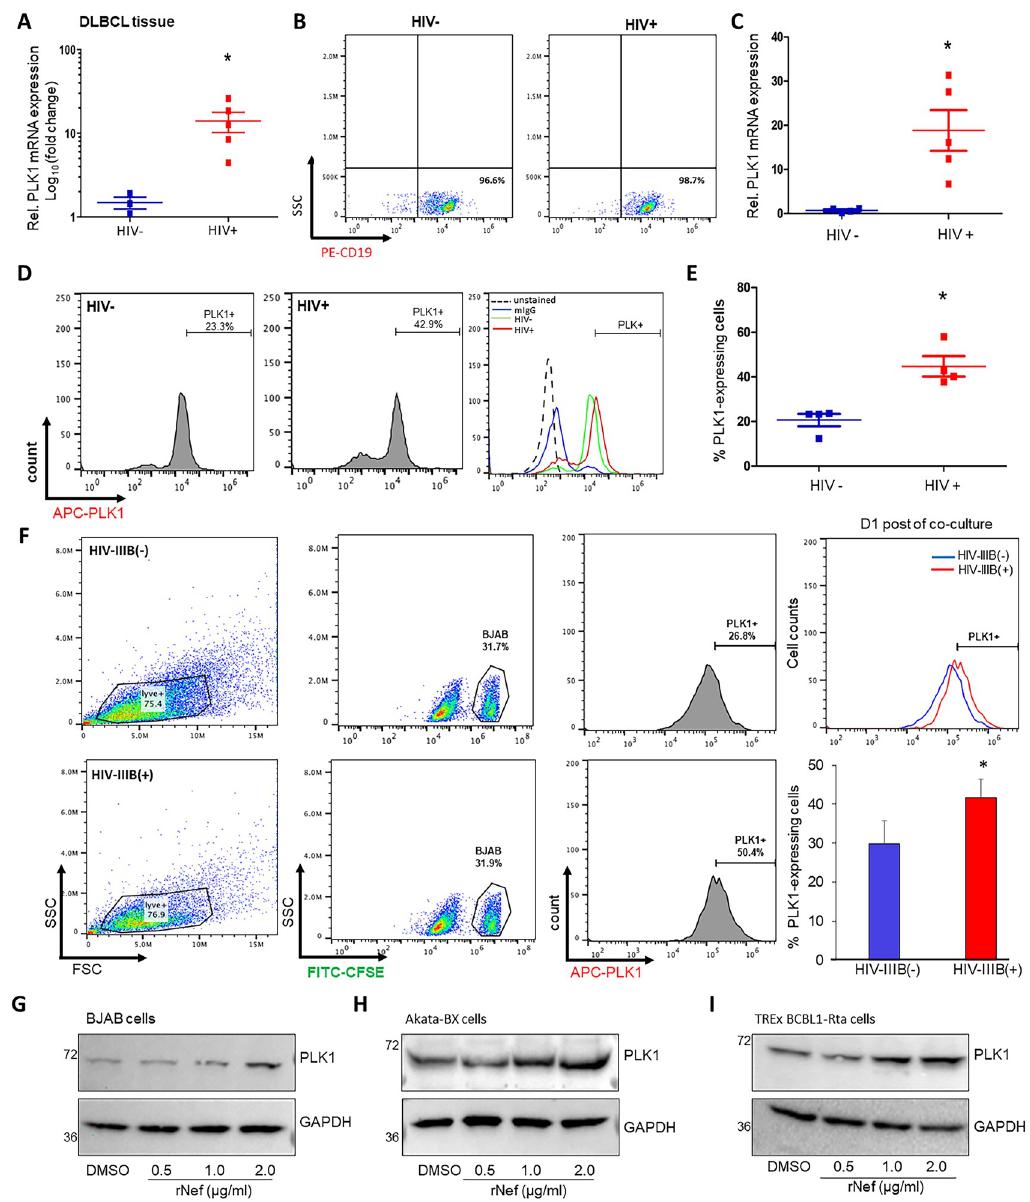
Fig 7. PLK1 expression is induced in B cells in the context of HIV infection. (A) Total RNAs were extracted from the fixed diffuse large B-cell lymphoma (DLBCL) tissue samples of HIV-negative (HIV-, n = 3) and HIV-positive (HIV+, n = 5) individuals. mRNA level of PLK1 in these tissue samples was measured by RT-qPCR and normalized to GAPDH. (B) A PE- conjugated CD19 antibody was used for B cell enrichment from PBMCs of HIV-infected, aviremic patients (HIV+, n = 5) or healthy donors (HIV-, n = 5). Purity of isolated CD19 + B cells was confirmed by flow cytometry analysis. (C) mRNA level of PLK1 in above isolated B cells (B) was measured by RT-qPCR and normalized to GAPDH. (D) Protein level of intracellular PLK1 in above isolated B cells (B) was measured by immunofluorescence. Percentage of PLK1-expressing cells was determined by flow cytometry analysis. (F) HIV-1 IIIB infected Jurkat cells were co-cultured with BJAB cells that were pre-stained with CFSE. Protein level of intracellular PLK1 in CFSE-labeled BJAB cells was measured by immunofluorescence. Percentage of PLK1-expressing cells was determined by flow cytometry analysis. (G-I) Protein level of PLK1 in BJAB (G), Akata-BX1 (H), or TREx BCBL1-Rta (I) cells treated with recombinant Nef (rNef) protein at the increasing dose or DMSO was measured by immunoblotting. GAPDH was used as loading control. Results were calculated from n = 3 independent experiments and presented as mean ± SD ( � p < 0.05; two-tailed paired Student